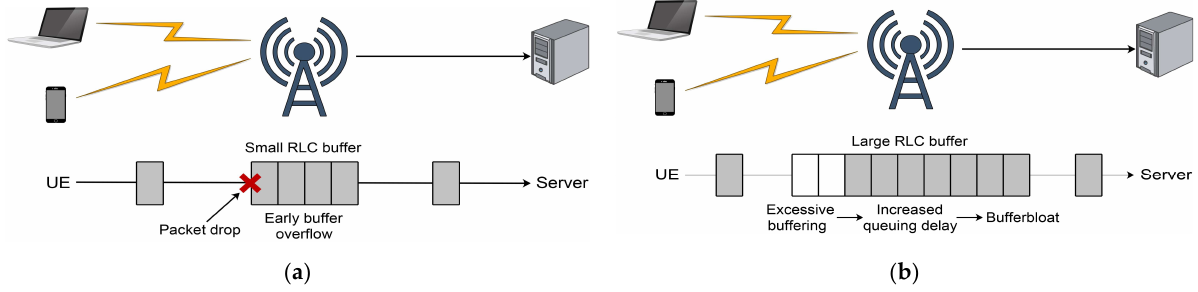
Figure 13. Different buffer size implementations: ( a ) packet drops due to a small RLC buffer, ( b ) bufferbloat problem due to a large RLC buffer.